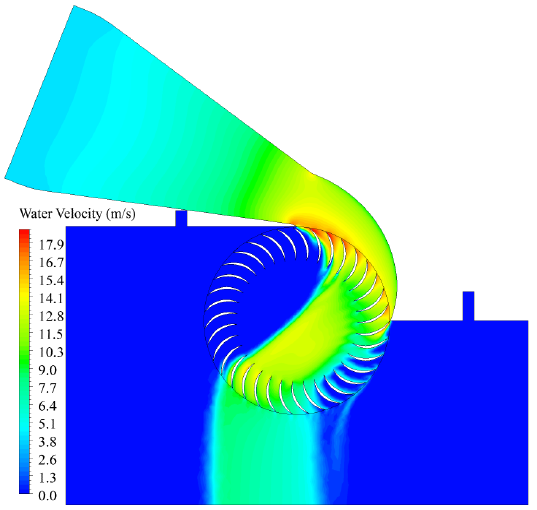
Figure 18. Water velocity field contours.